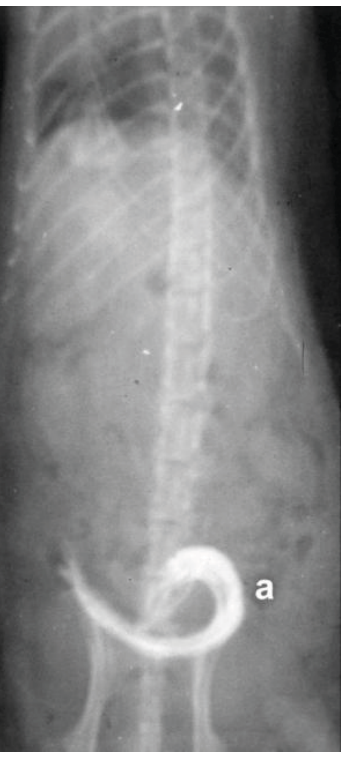
Figure 2. A control rat 24 h after CM administration. Some of the CM is present in the large bowel.